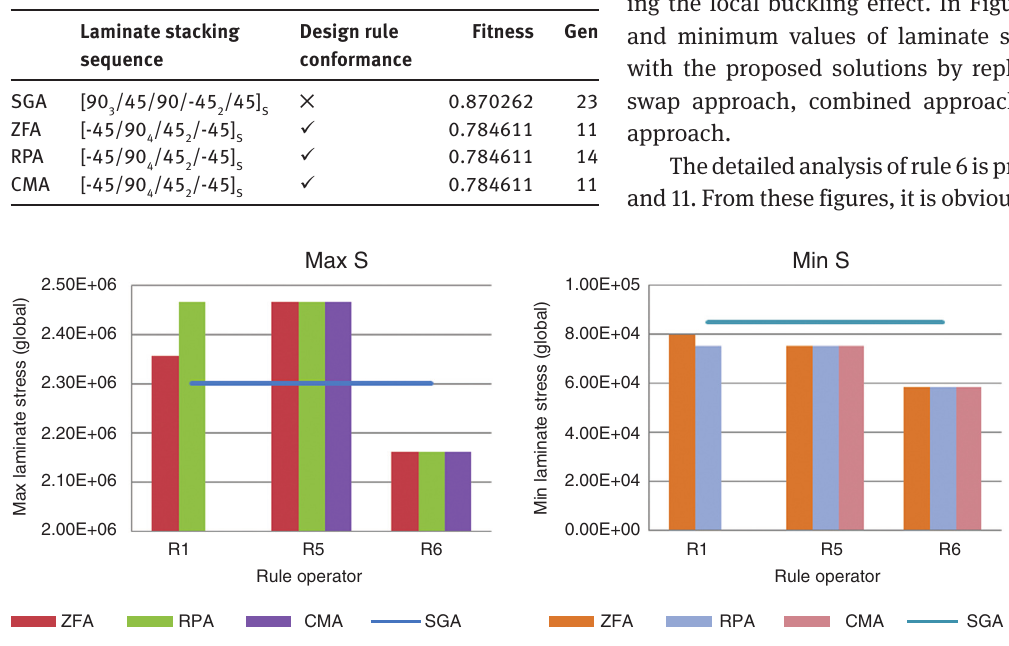
Figure 9 Maximum and minimum global laminate stress analysis using envelope absolute tool.